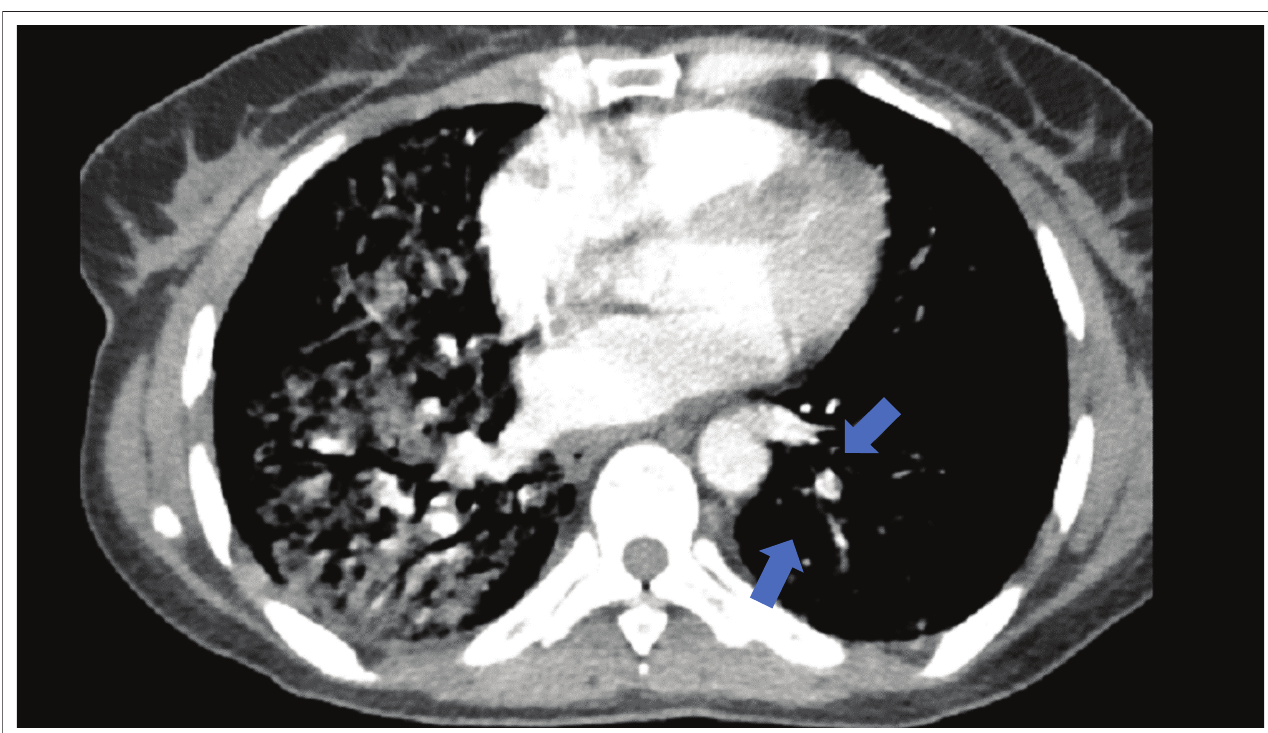
FIGURE 2: Computed tomography pulmonary angiogram showing filling defect in left lower lobe subsegmental pulmonary